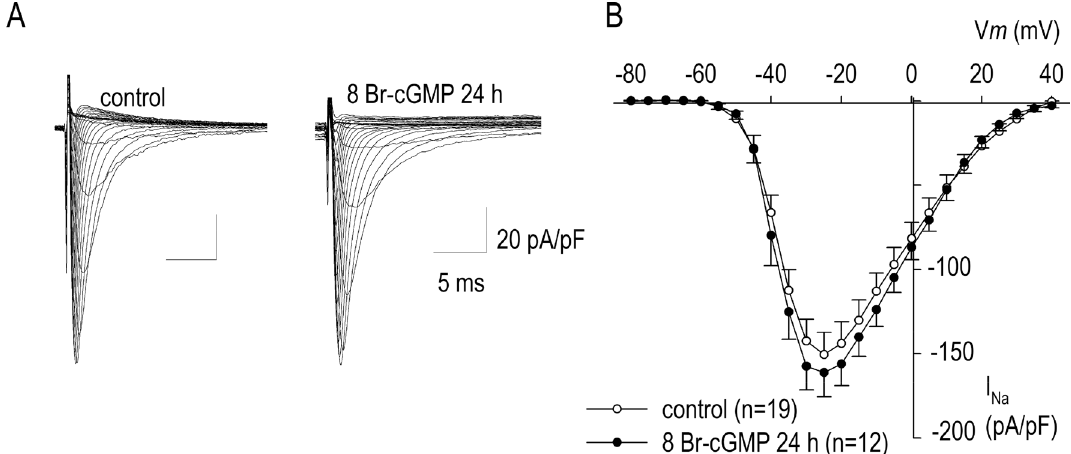
Figure 6. Effects of a membrane-permeable analog of cGMP (8Br-cGMP) on I Na . ( A , B ) Representative I Na traces with vehicle and 500 μM 8Br-cGMP applied for 24 h, and their I–V relationships of I Na . 8Br-cGMP was unable to modify I Na . Numbers of cell are shown in parentheses. Values represent the mean ±